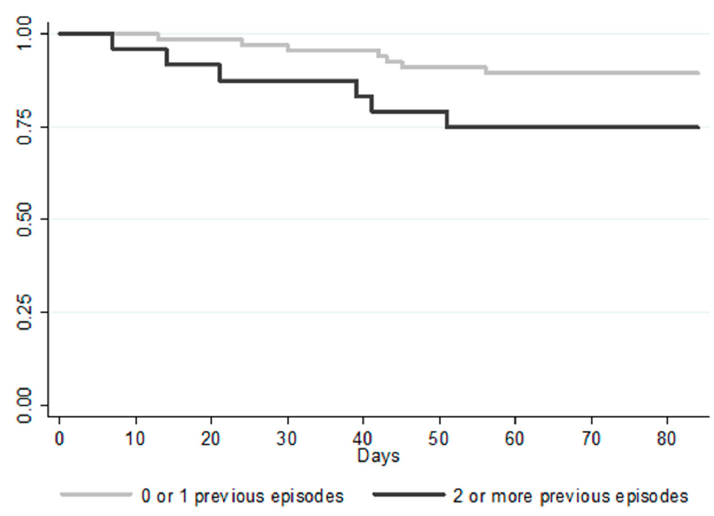
Figure 2. Kaplan–Meier plot of time to recurrent CDI.